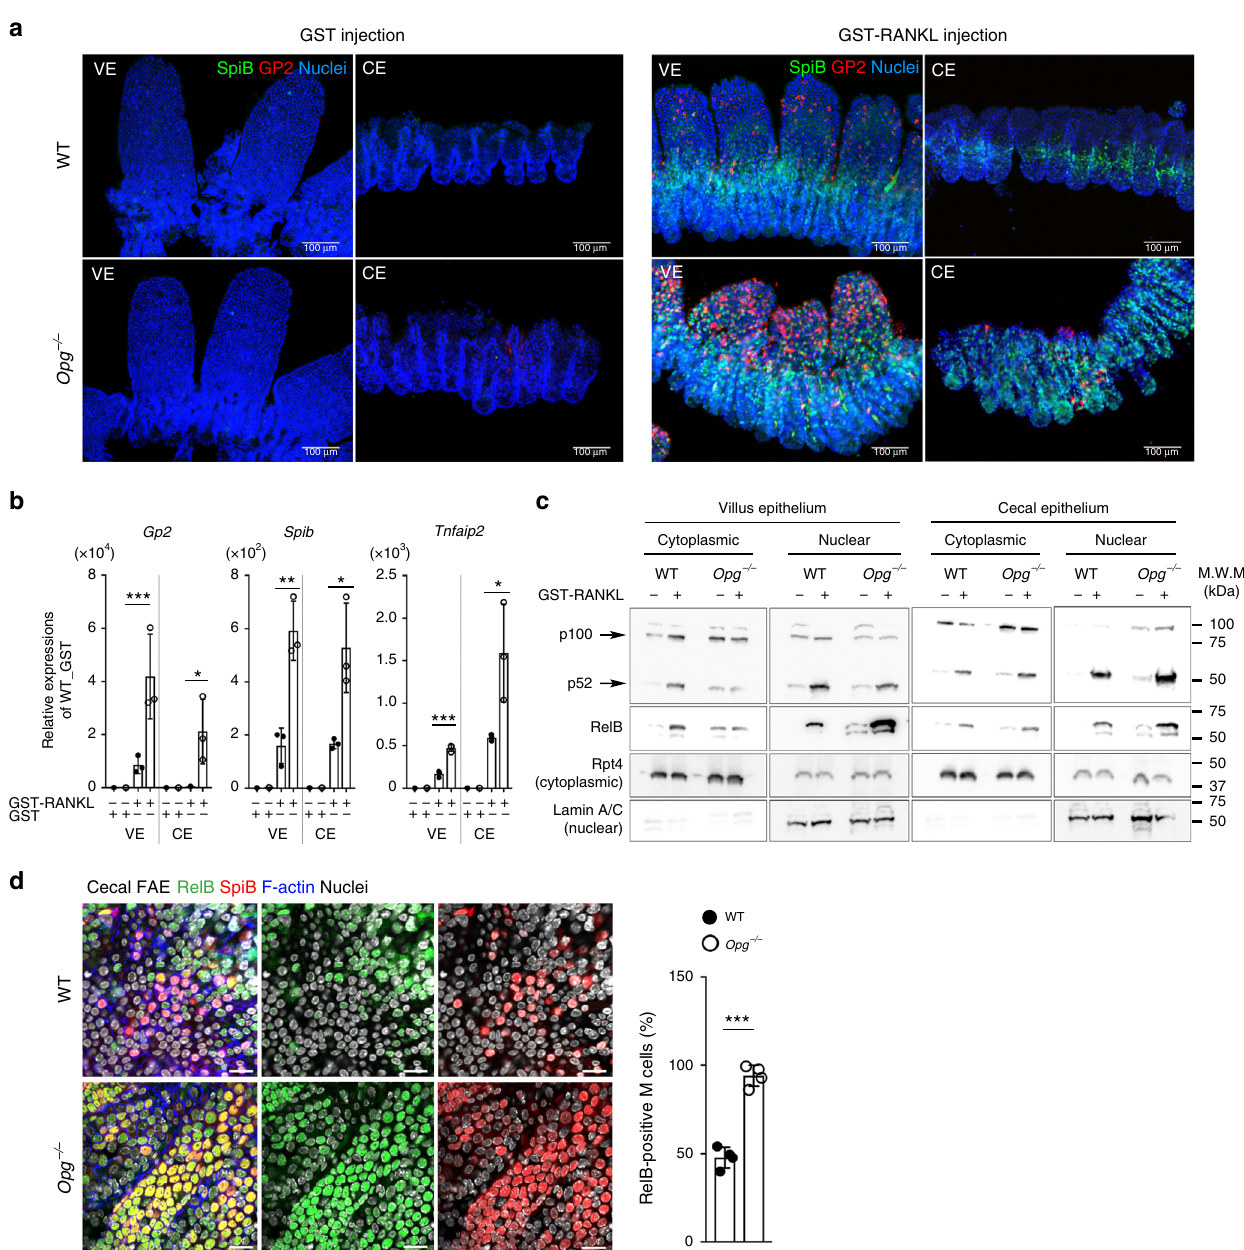
Fig. 4 RANKL – RANK signaling is stimulated in the gut epithelia of Opg − / − mice. a GP2 + cells (red) are more effectively induced in the cecal epithelium (CE) and ileal villi (VE) of Opg − / − mice by RANKL administration. Whole-mount immunohistochemical images of Spi-B (green) and GP2 (red) in the VE and CE of WT (upper panels) and Opg − / − mice (lower panels) treated with either GST (control; left) or GST-RANKL (right). Scale bars: 100 µ m. Representative images from three independent experiment are shown. b Quantitative PCR analysis of M-cell marker expression in conventional epithelia from the VE and CE of mice injected with GST (control) or GST-RANKL. Results were normalized to Gapdh expression and are presented relative to the expression in the ileal epithelium from GST-treated mice. Data shown are mean values from three independent experiments (error bars indicate standard deviation). *** p < 0.005, ** p < 0.01, * p < 0.05; p values were calculated with the Student ’ s t -test ( n = 3 biologically independent experiments). c , d Nuclear translocation activities of RelB and p52 following RANKL stimulation are enhanced in Opg − / − mice. c Western blot analysis of p100/p52 and RelB in the VE and CE of mice injected with GST or GST-RANKL. Rpt4, a subunit of the 26S proteasome, was used as an internal control for the cytoplasmic fraction. Lamin A/C (Lamin) was used as an internal control for the nuclear fraction. Data are representative of two independent experiments. d Right, single confocal planes of the cecal FAE from WT and Opg − / − mice. FAE monolayers were stained with anti-RelB (green) and anti-Spi-B (red) antibodies and with Hoechst 33342. Left, a bar graph summarizing the proportions of RelB-positive cells among total numbers of M cells (Spi-B-positive cells). *** p < 0.005; p values were calculated with the Student ’ s t -test ( n = 4 biologically independent experiments). Scale bars: 20 µ m. The source data underlying panels b and d and non-cropped scan images of western blotting ( c ) are provided as a Source Data fi